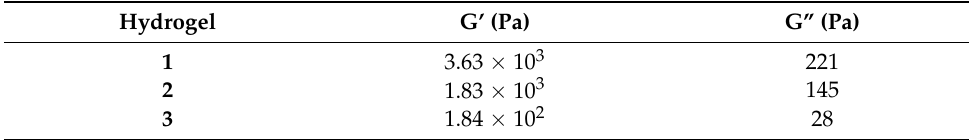
Table 2. G’ and G” for hydrogels 1 – 3 at 0.20 Table 2. G’ and G’’ for hydrogels 1 – 3 at 0.20 wt%.